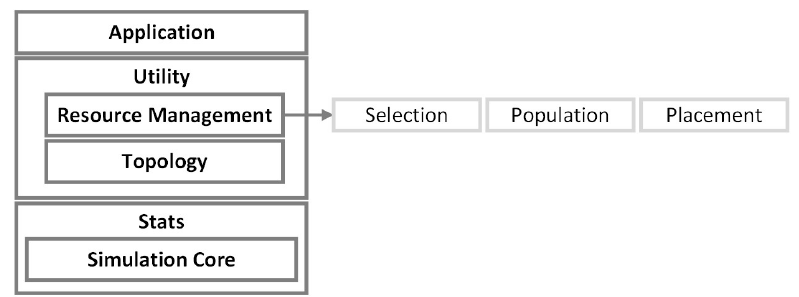
Figure 5. YAFS architecture (Adapted from [22]).